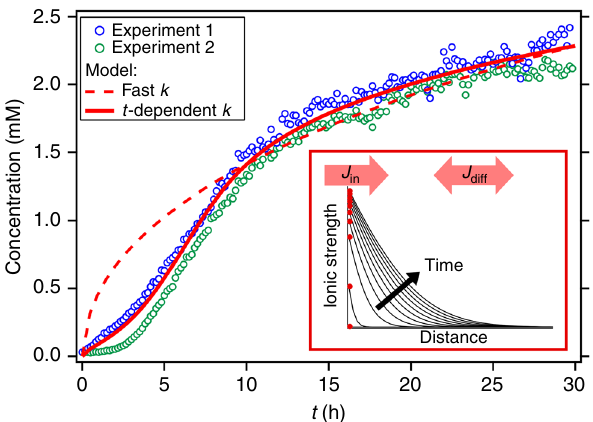
Fig. 4 Time trace. The time trace of the O – H-stretch SFG signal from the silica/water interface for pure water converted into an interfacial ionic strength (circles) by using the conversion function detailed in Supplementary Note 2. For comparison, the interfacial ionic strength as predicted by a simple 1D dissolution/diffusion model (red lines). Inset: a schematic plot of the concentration gradient perpendicular to the surface plane resulting from the model, plotted at equally distant times. The red dots represent the evolution of the interfacial ionic strength (average value of the fi rst 1 μ m)